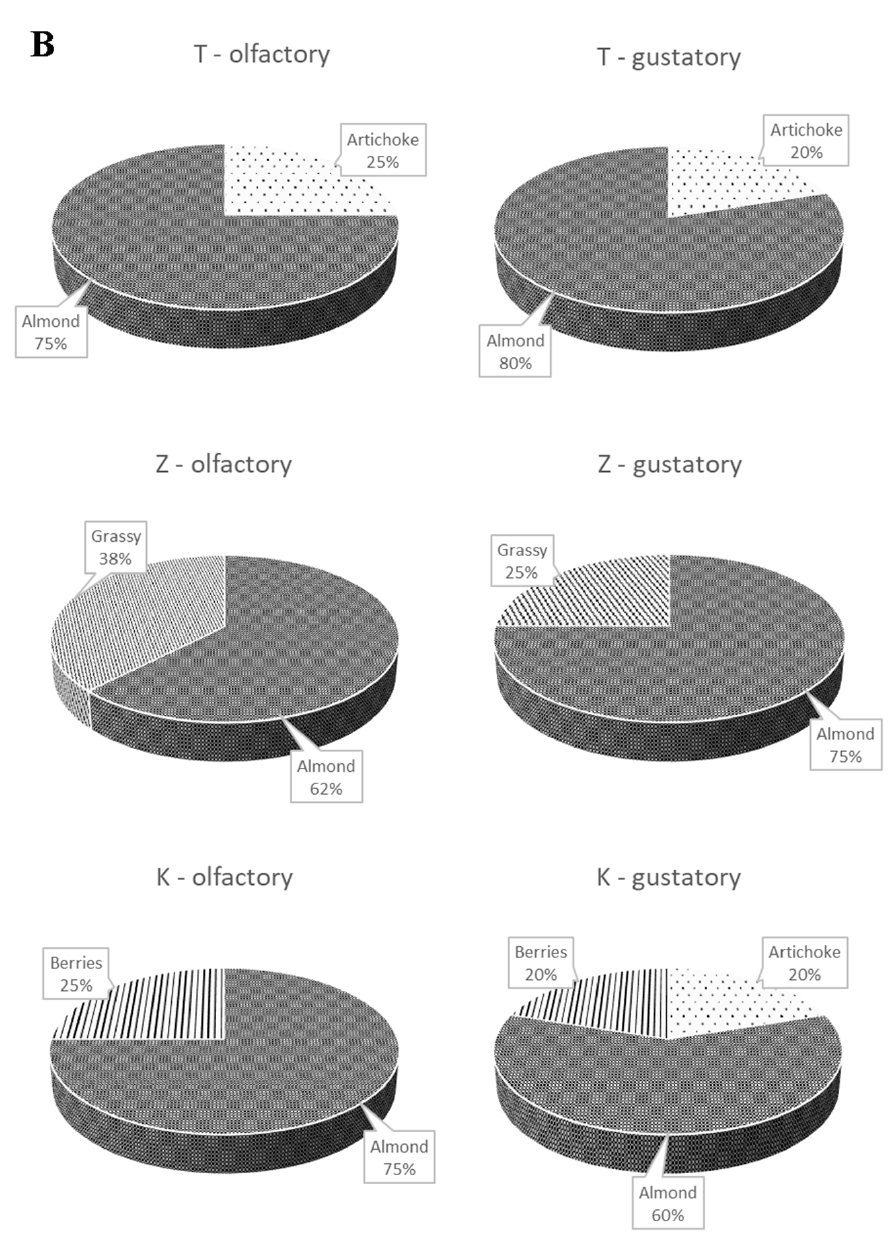
Figure 3. ( A ) Sensory profiles of olive oils produced by plants treated with particle films of CHA- zeolitite (Z), kaolin (K) and untreated plants (T). ( B ) Gustatory and olfactory pleasant flavors of olive oils produced by plants treated with CHA-zeolitite (Z), kaolin (K) and untreated plant (T). These differences in the typology of pleasant flavours were also corroborated by the results of the triangular test sensory analysis carried out to evaluate if the foliar treatments could determine sensory differences in comparison to T oil. The minimum number of correct responses required to conclude that there is a perceptible difference is 20 ( α 0.001). The oil produced with plants treated with CHA-zeolitite particle film (Z) did not differ from the T oil (8 correct answers); in fact, the difference between grassy notes and artichoke was not statistically perceived by assessors. The oil produced by plants treated with kaolin particle film (K) was judged to be different from the untreated T oil (22 correct answers). The triangular test does not allow identification of how the K oil differs from the T oil; we highlighted that, using QDA results, no sensory defects or off-flavor were reported by assessors, leading us to argue that the perceived difference due to kaolin treatments